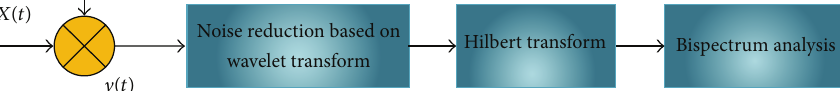
Figure 1: Scheme for fault diagnosis.